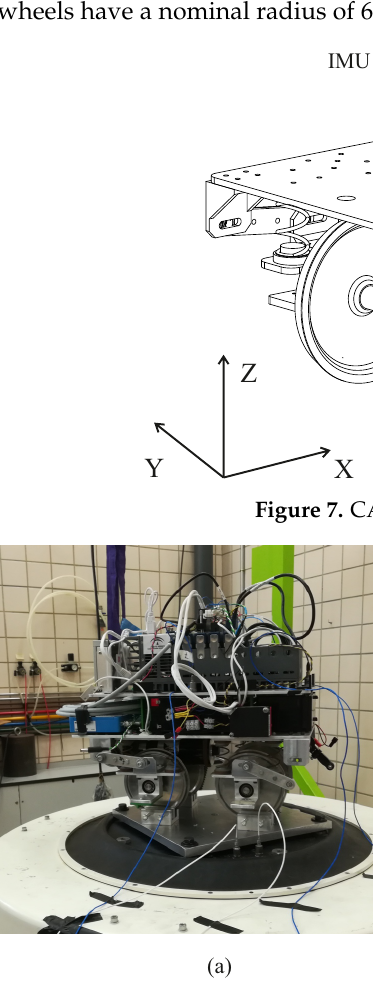
Figure 8. ( a ) Experiment in the vertical direction. ( b ) Experiment in the lateral